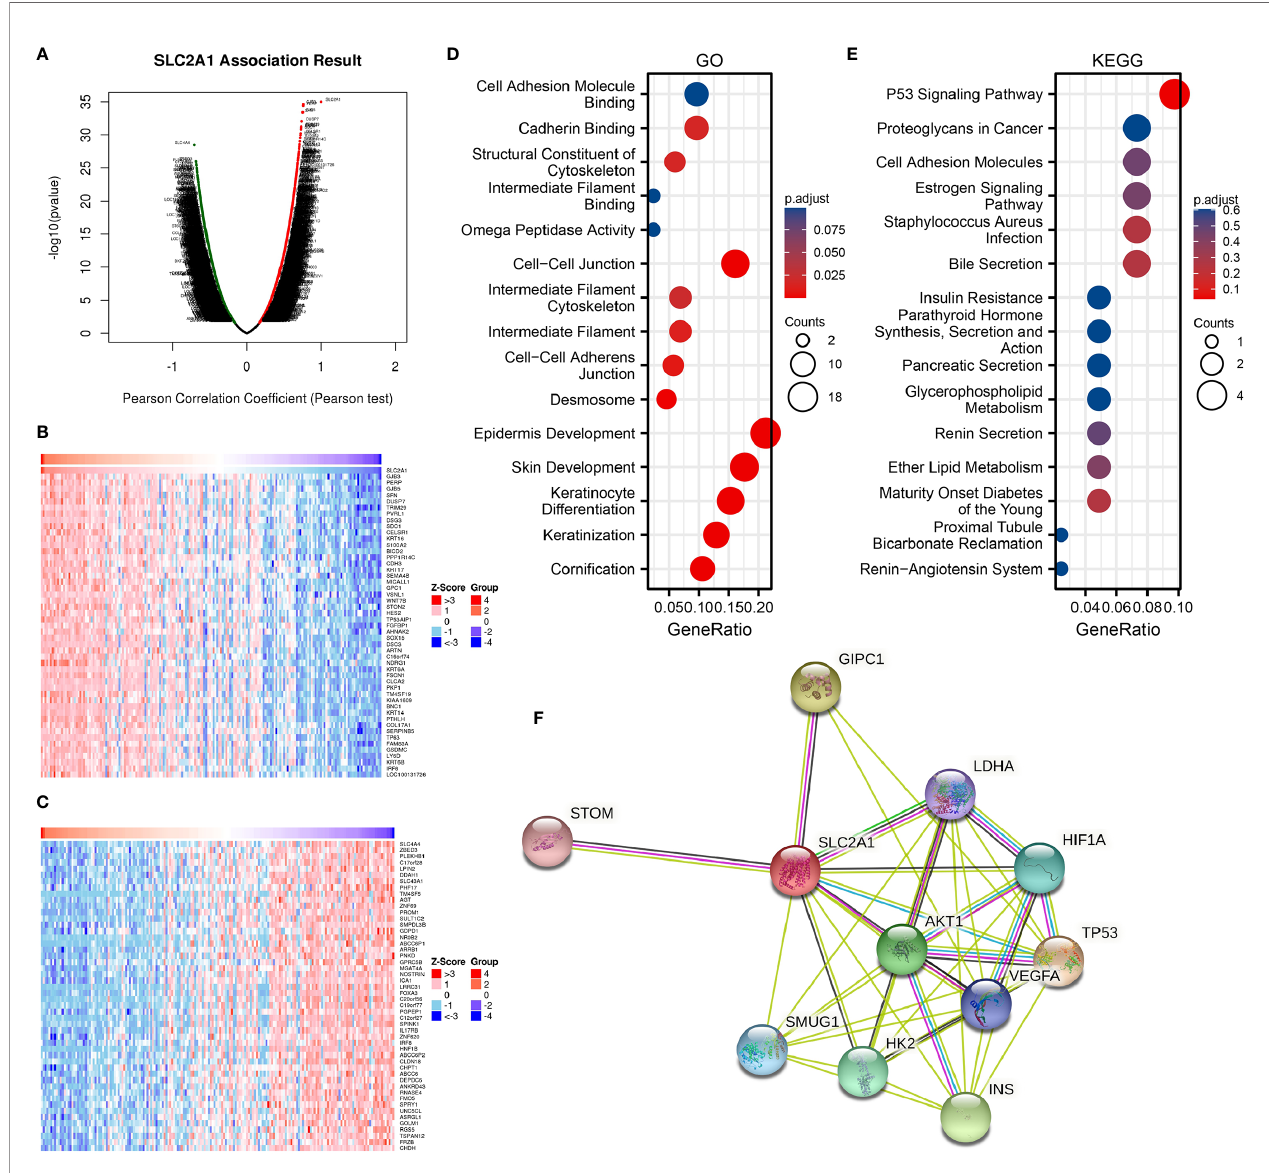
FIGURE 2 | Enrichment analysis of GLUT1 functional networks in esophageal carcinoma (ESCA). (A) Genes highly related to GLUT1 identi fi ed in the ESCA cohort by Pearson test. (B) The heat map shows the top 50 genes positively related to GLUT1 in the ESCA cohort. (C) The heat map shows the top 50 genes negatively related to GLUT1 in the ESCA cohort. (D) Enrichment of gene ontology (GO) terms for genes related to GLUT1. (E) Enrichment of Kyoto Encyclopedia of Genes and Genomes (KEGG) terms for genes related to GLUT1. (F) Protein – protein interaction network of